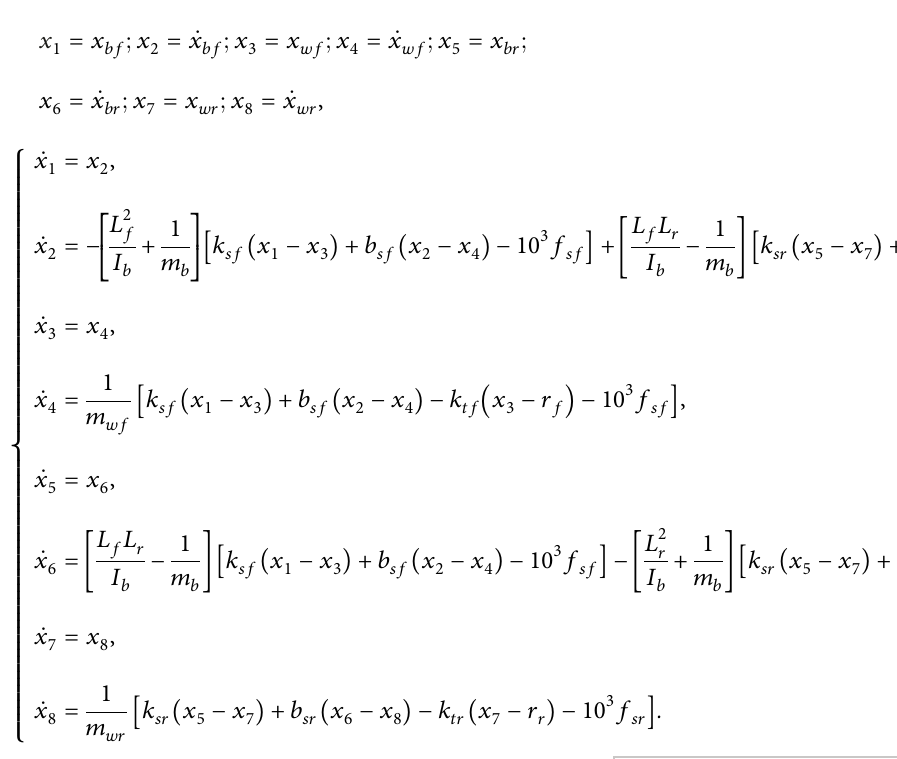
Table 1 provides a summary of the input-state-output variables correlated with the active suspension model. table, and